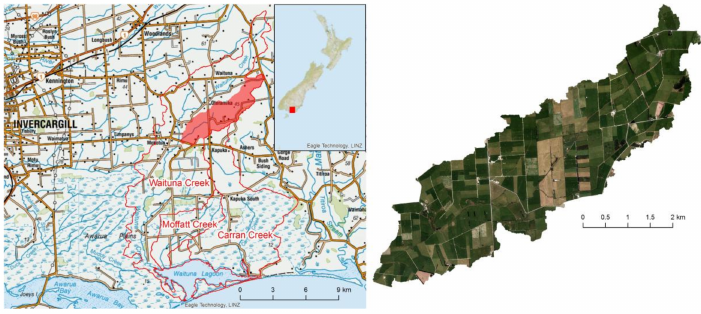
Figure 1. Study area (marked red) in in the Waituna Creek Catchment and orthophoto showing land